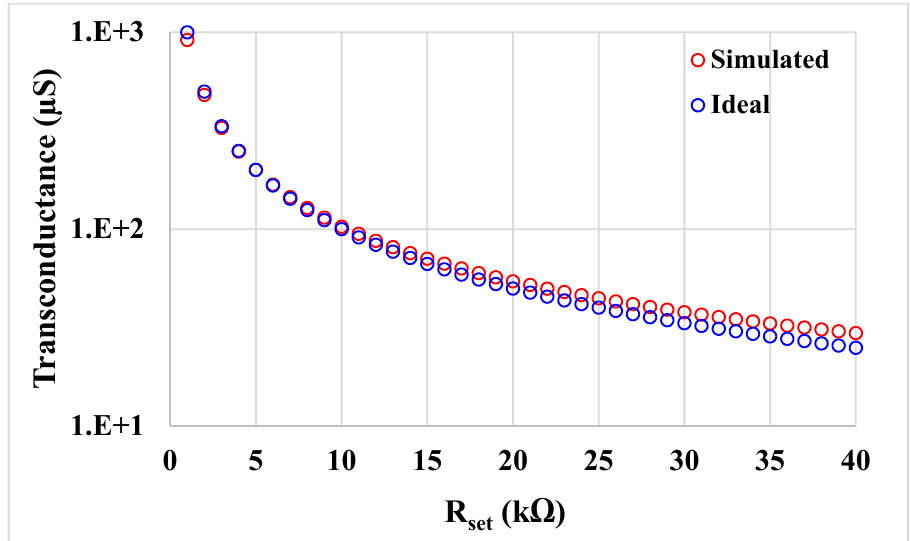
w / V n | and | V w / V z |.